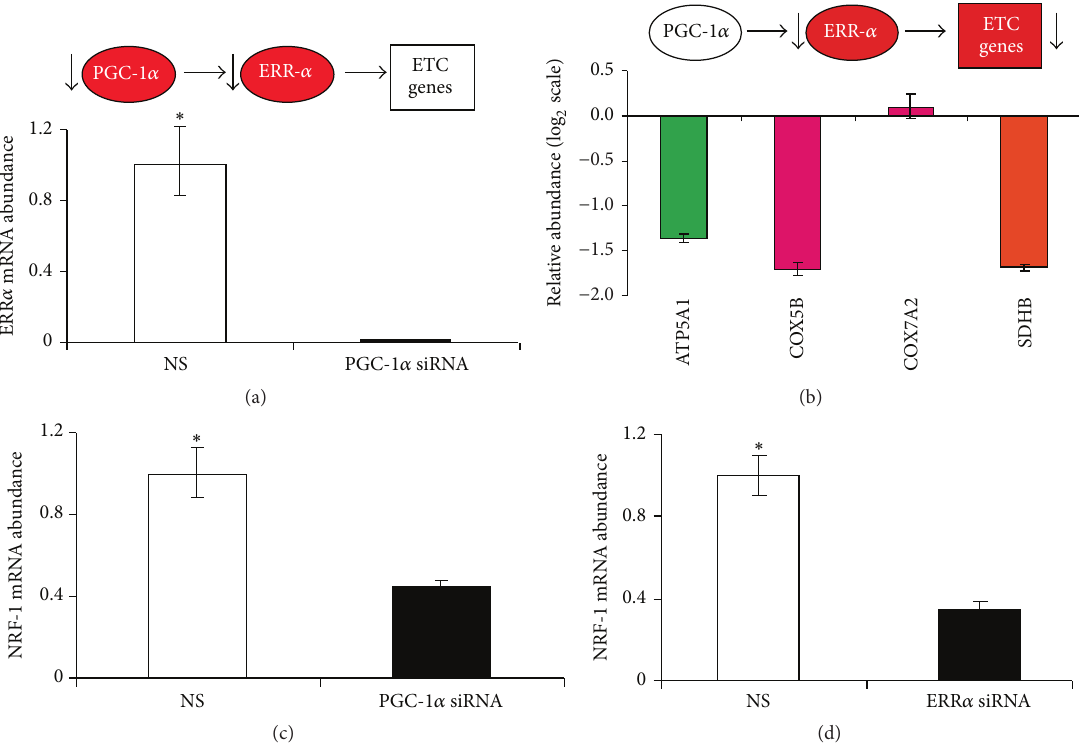
Figure 2: The orphan nuclear estrogen-related receptor 𝛼 ( ERR 𝛼 ) is an early target of endogenous, neuronal PGC-1 𝛼 . (a) Silencing of neuronal PGC-1 𝛼 repressed the expression of endogenous ERR 𝛼 by more than 90%, respectively, compared to controls transfected with scrambled siRNAs (NS). Model circuit and observed effects in circuit components are shown. (b) Silencing of ERR 𝛼 largely recapitulated the reduction in electron transport chain gene expression observed in response to PGC-1 𝛼 -silencing (note log 2 scale). NRF1 gene expression was downregulated by more than 50% by silencing PGC-1 𝛼 (c) or ERR 𝛼 (d). The ribosomal gene RPL13 was used as control for input RNA. Mean ± SEM shown ( 𝑁 = 3 for each set). ∗ denotes 𝑃 value ≤